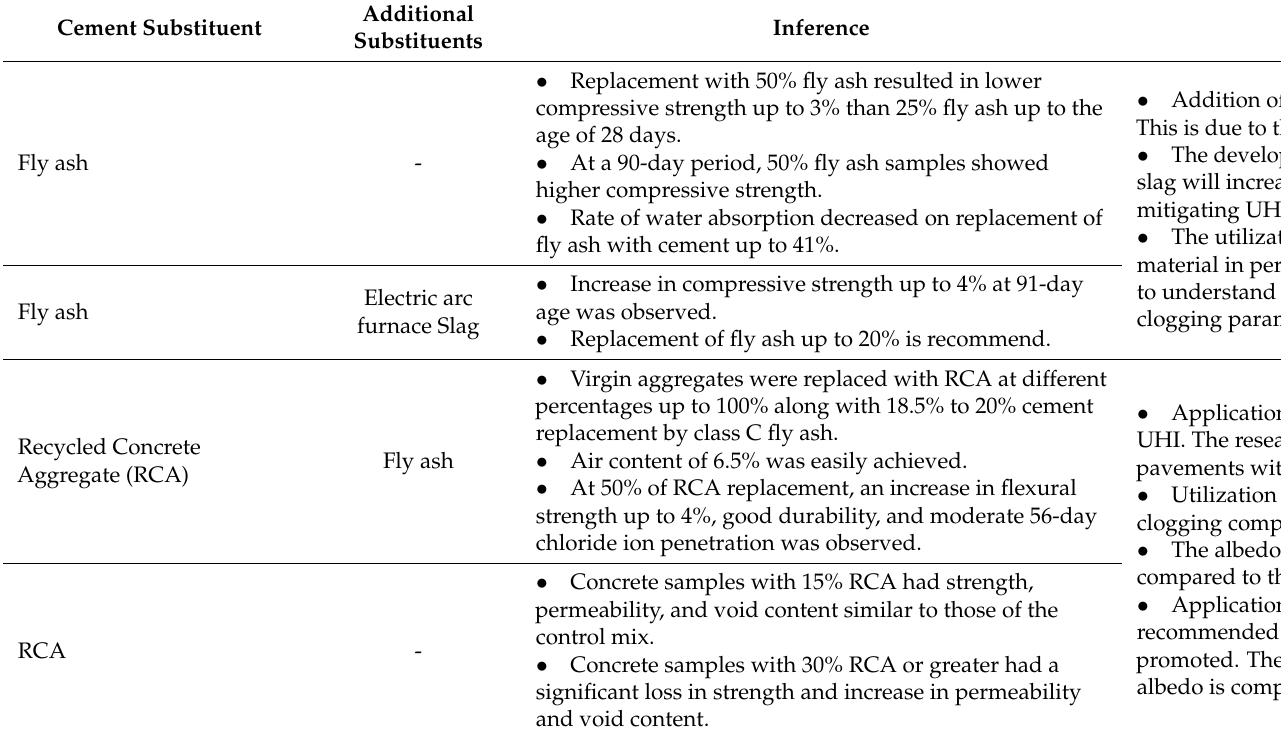
Table 3. Summary of application of industrial by-product waste materials in